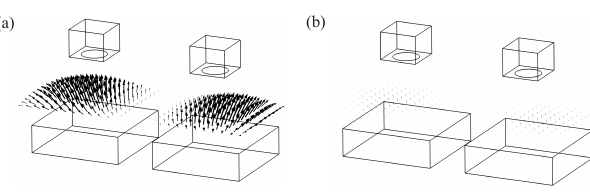
Figure 7: Active sound intensity on plane at h /4 in front of the PNSs for h / λ = 0.18 . (a) primary, (b) residual (TASPM).